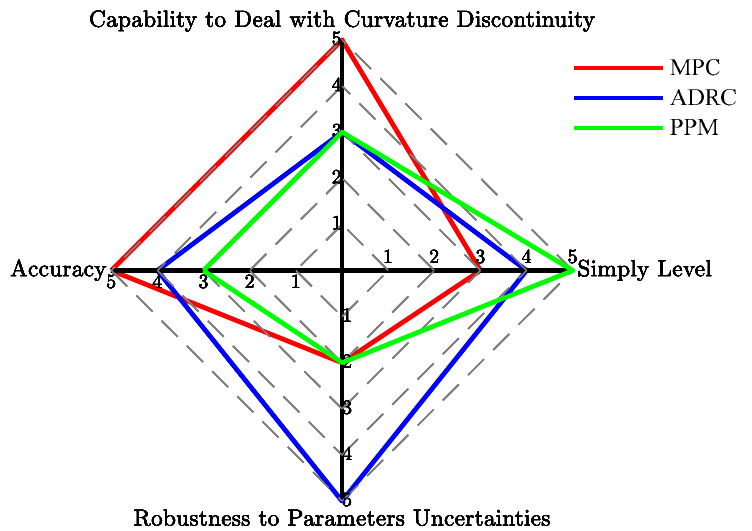
Figure 12. Radar schematic of KPI score of the proposed lateral controllers.